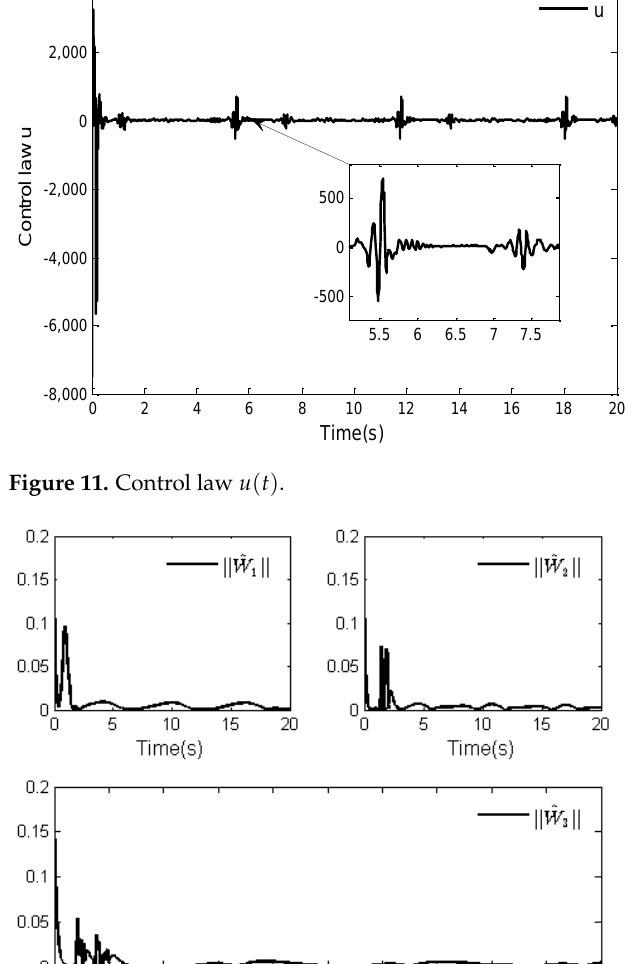
ˆ W . i (cid:13) (cid:13) ˆ (cid:13) . (cid:13) ˆ W i W . Figure 12. Norms of adaptive laws ˆ W . i i